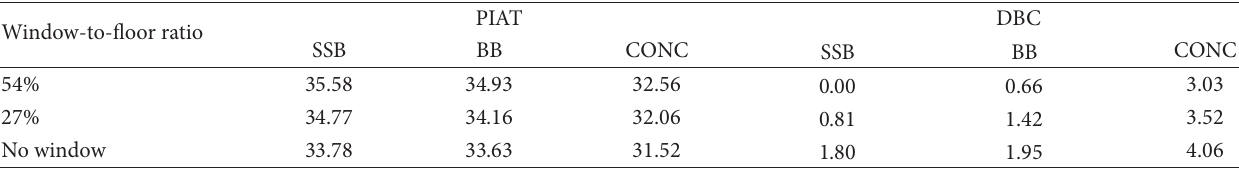
Table 4: Indoor air temperature models with varied window patterns.